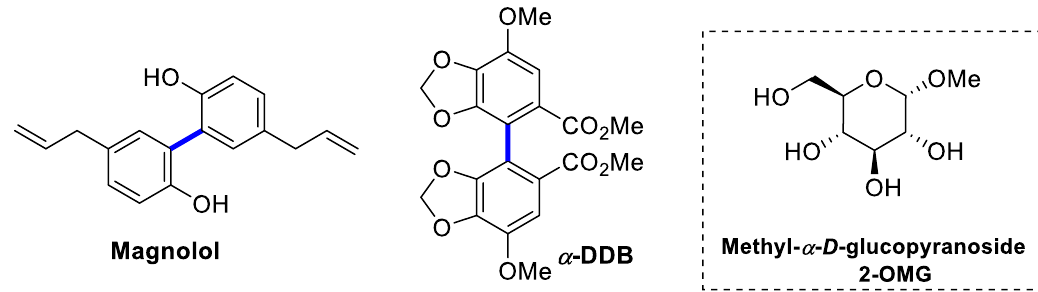
Figure 1. Chemical structures of some symmetrical biaryls and